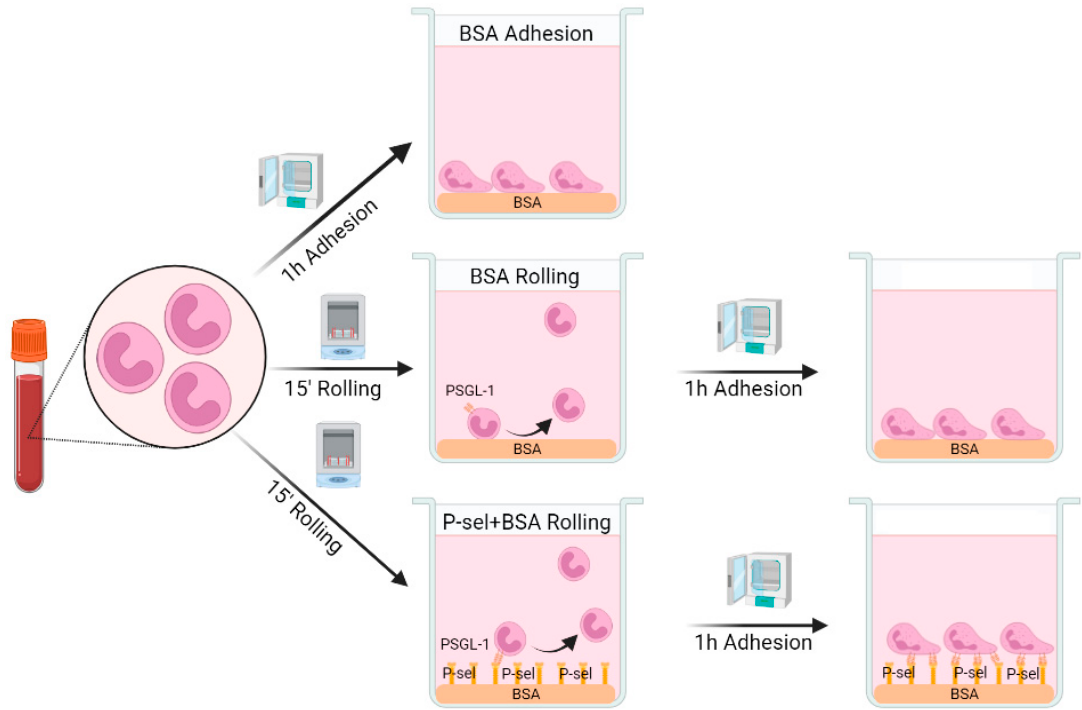
Figure 7. Rolling-like assays in neutrophils isolated from peripheral blood. Created with Bioren- der.com .